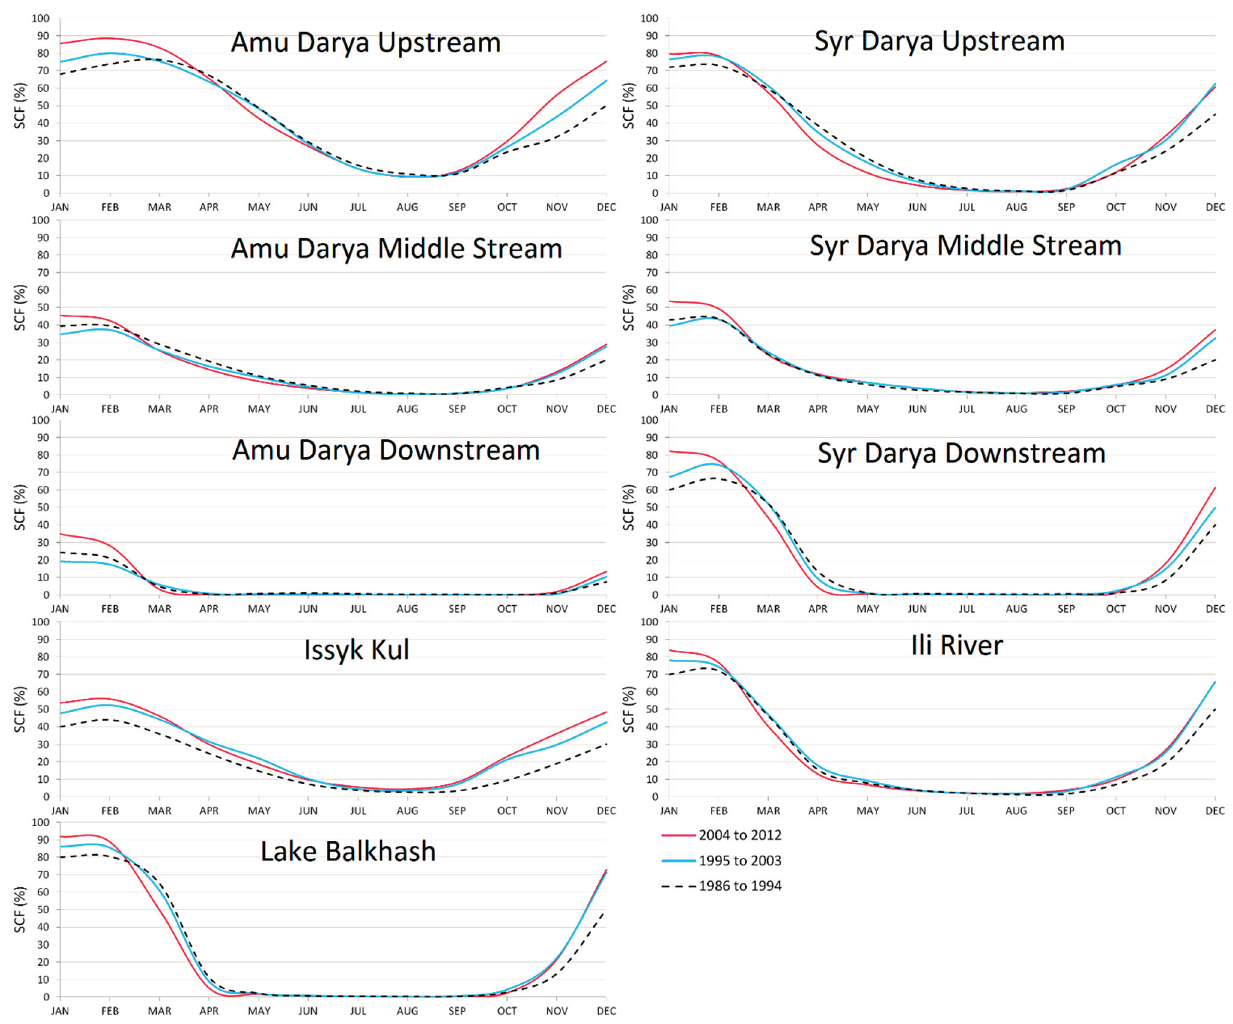
Figure 9. Mean Snow Cover Fraction (SCF) for eight-year periods between 1986 and 2012 for Upstream, Middle Stream, and Downstream catchments of Amu Darya, Syr Darya, and Lake Balkhash catchment